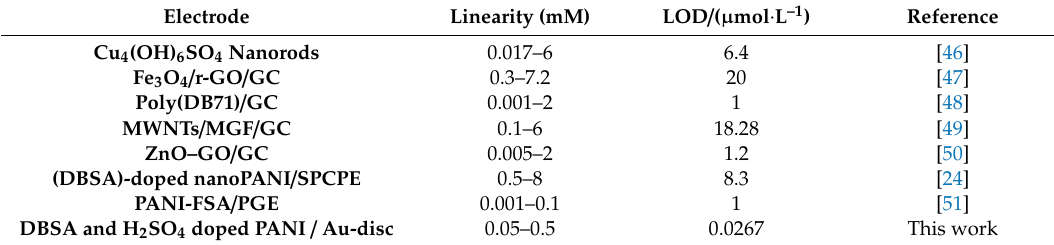
Table 1. Comparison of synthesized PANI electrode performance with previously reported data.